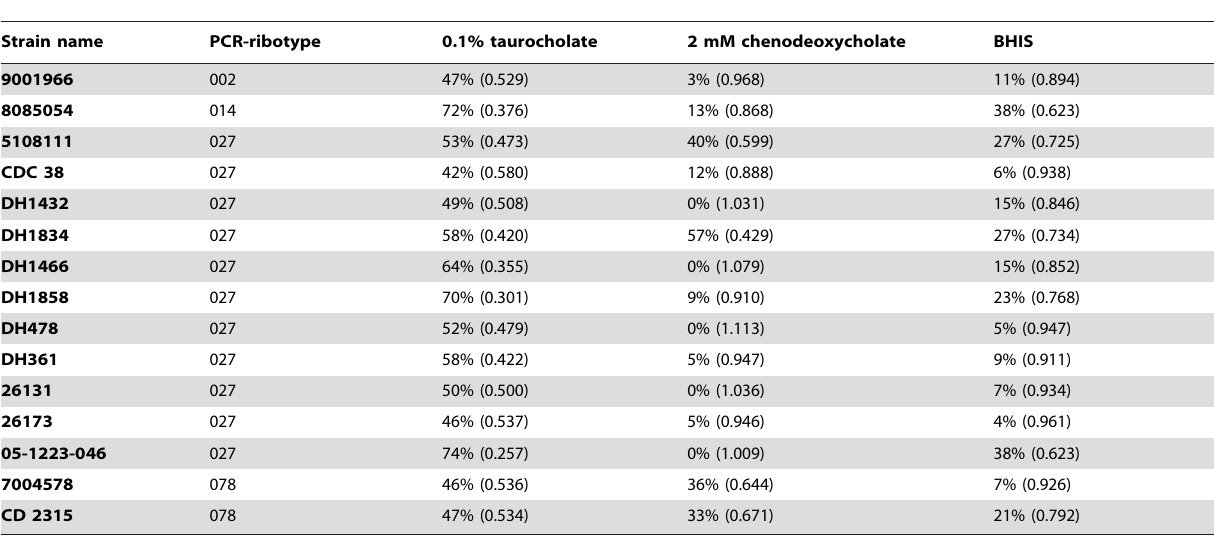
Table 2. Percentage loss of spore optical density after incubation of C. difficile spores with bile salts for 2 h.